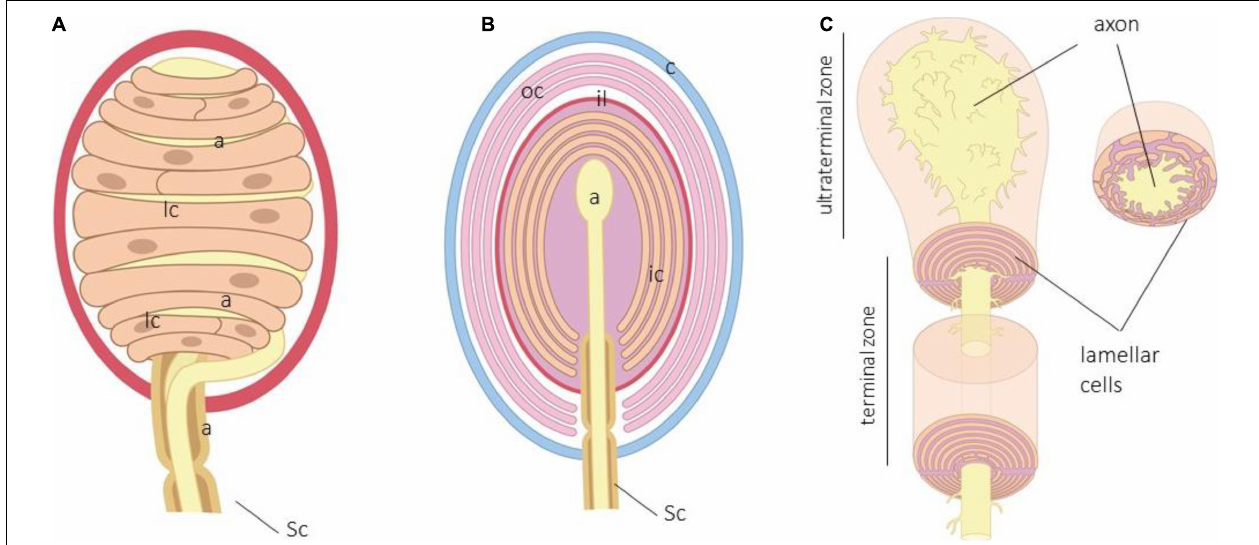
FIGURE 1 | (A) Schematic representation of human digital Meisser. a, axon; c, capsule; lc, lamellar cells, Sc, Schwann cells. Lamellar cells in Meissner corpuscles are closely related to the axon and form a “coin stack.” (B) Schematic representation of human Pacinian corpuscle. a, axon; c, capsule; ic, inner core; il, intermediate layer; lc, lamellar cells; oc, outer core; Sc, Schwann cells. (C) Arrangement of the terminal glial cells in the terminal and ultraterminal zones of the inner core.